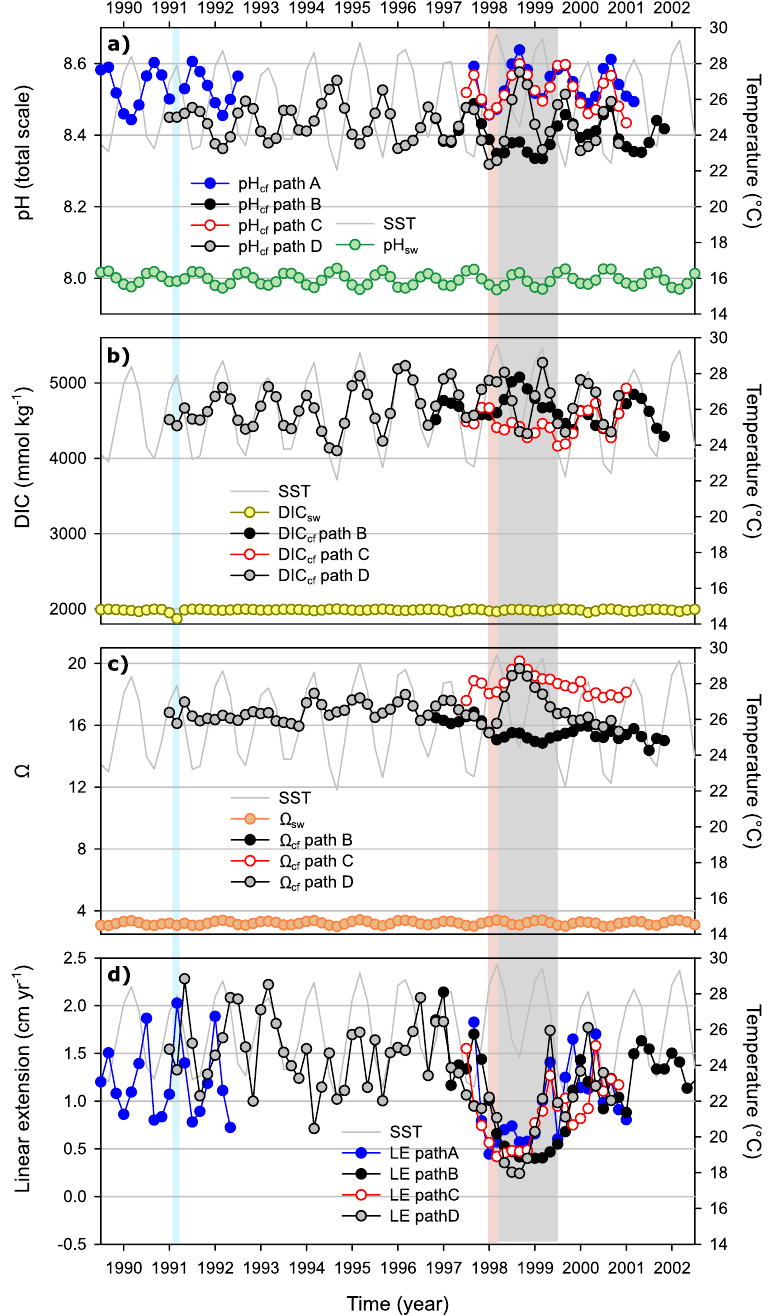
Figure 7. Coral bimonthly (interpolated) reconstructions of ( a ) pH cf , ( b ) DIC cf , ( c ) Ω cf and ( d ) linear extension (calculated from trace element age model) compared against modelled seawater pH (pH SW ), seawater inorganic carbon (DIC SW ) and seawater aragonite saturation state (Ω SW ), respectively. SST records are shown in all panels for comparison purposes. The bimonthly pH SW , DIC SW and Ω SW records were modeled according to D’Olivo, et al . 40 (see supplementary). The pink shaded area highlights the timing of the 1998 bleaching event, the grey shaded area highlights the recovery period and the blue shaded area highlights the timing of the 1991 very large flood event. The increase in pH cf during the 1991 could be explained by the decrease in DIC cf following the dynamic control of the cf described in the